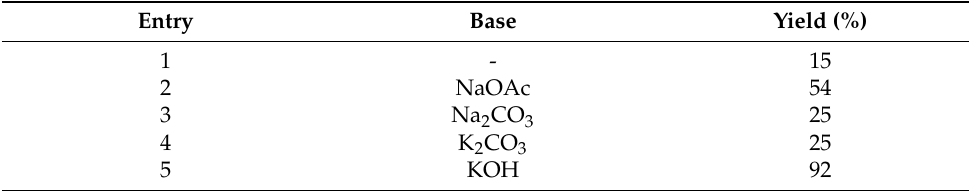
Table 3. Role of the base in the reaction a .